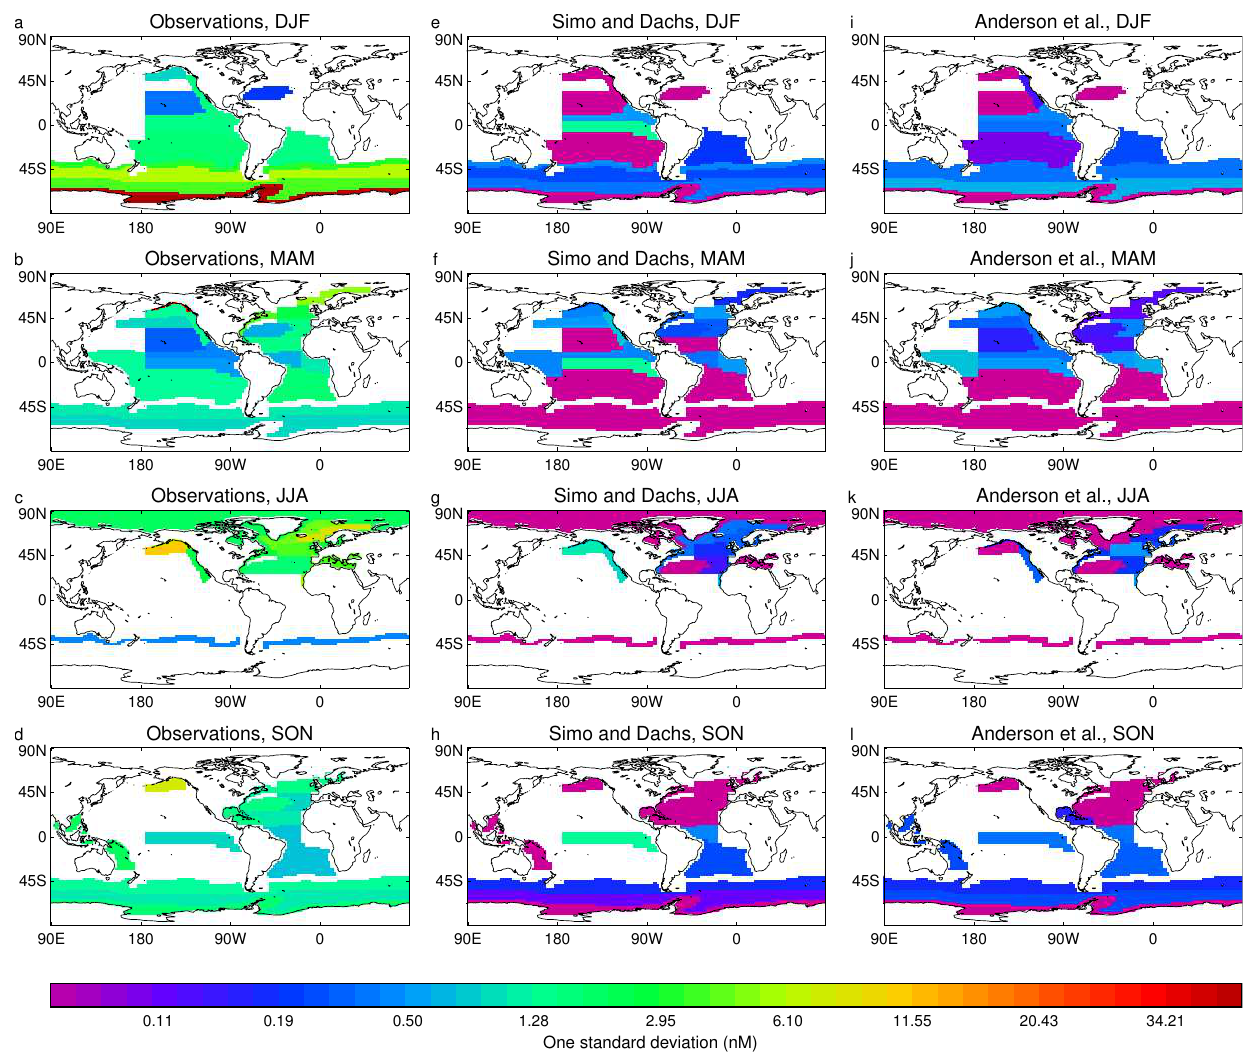
Fig. 4. Inter-annual variability in observations and model data. Colours represent the standard deviation of the mean values calculated for each biogeochemical province (Longhurst et al., 1995) for the named season in each year. Means were calculated using data from only the 1 × 1 degree grid-boxes which contain observational data. (a–d) Standard deviations calculated using data collected and input to the PMEL database between 1972 and 2009. (e–h) Standard deviations calculated using data generated by the model using the Simo (2002) parameterisation. (i–l) Standard deviations calculated using data generated by the model using the Anderson (2001) parameterisation. Only biogeochemical provinces within which, statistically significant inter-annual variability (see main text for details), or significant lack of inter- annual variability can be demonstrated, are shown. DJF, MAM, JJA and SOC refer to the months of Northern Hemisphere winter, spring, summer and autumn